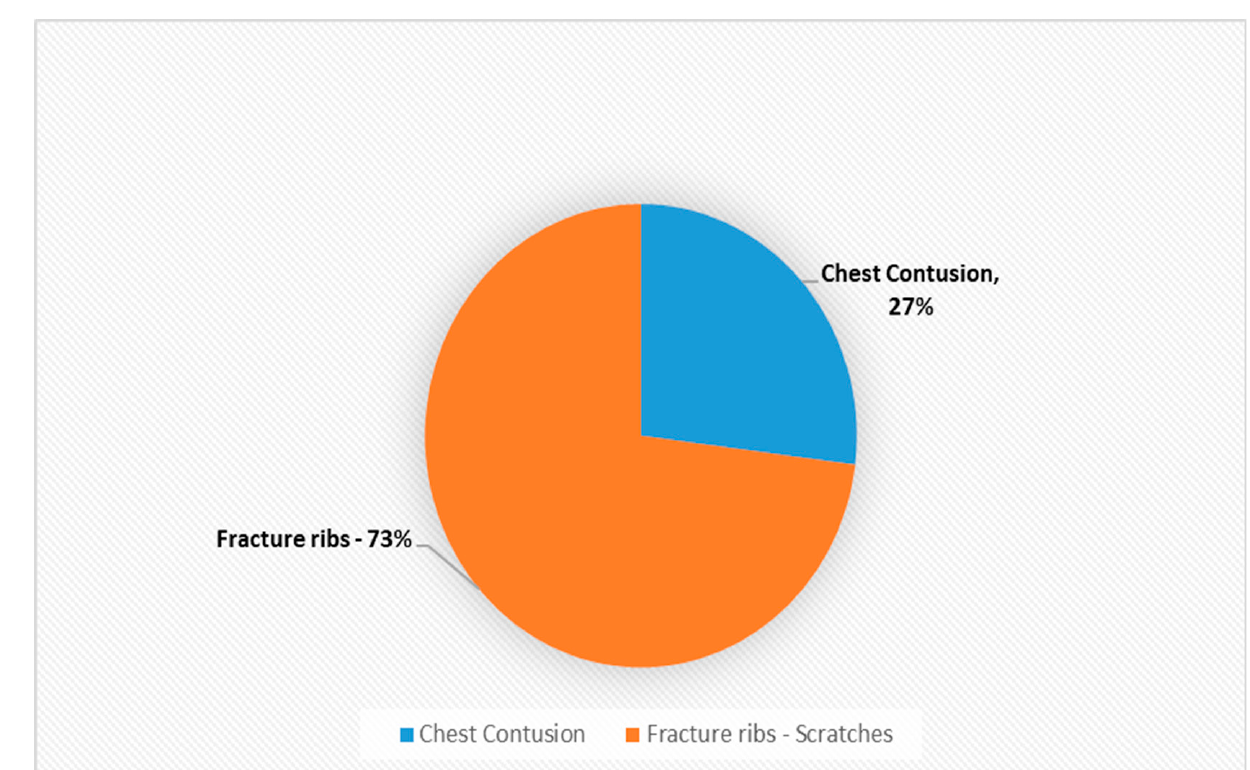
Figure 4. Composition of skin injuries as a % ( n = 32).